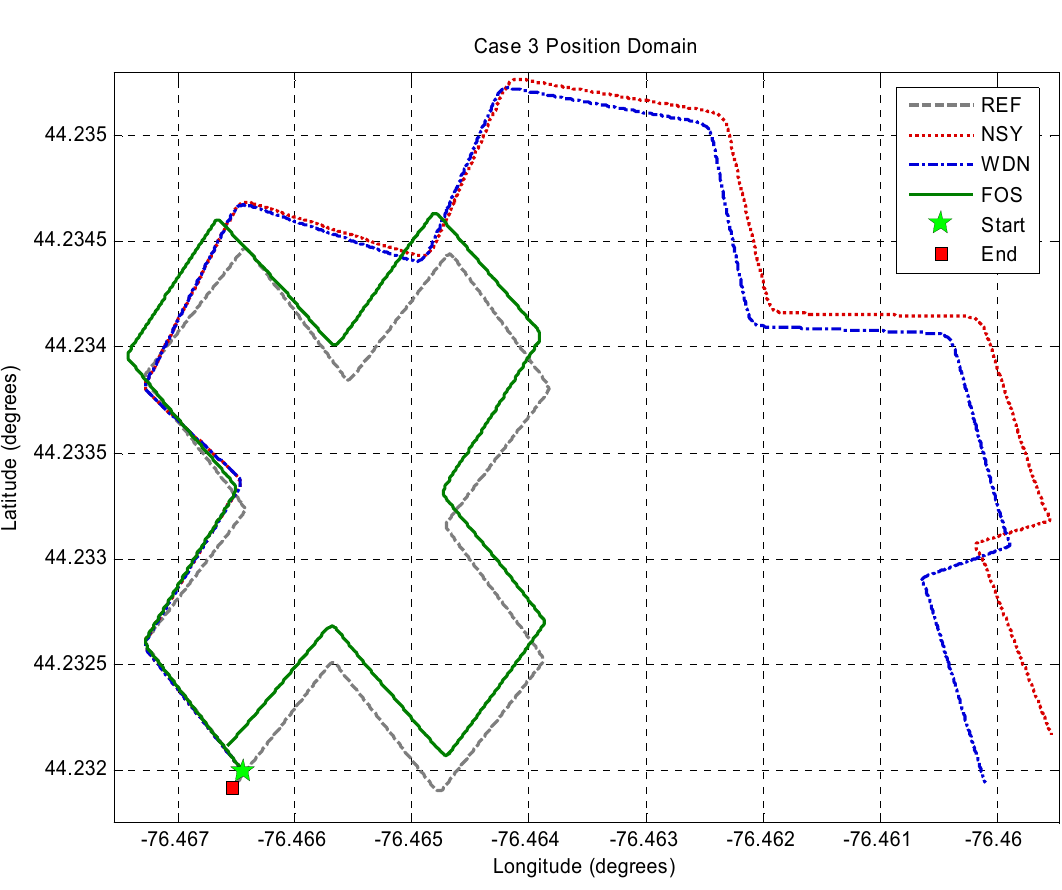
Figure 4. Trajectory plots.